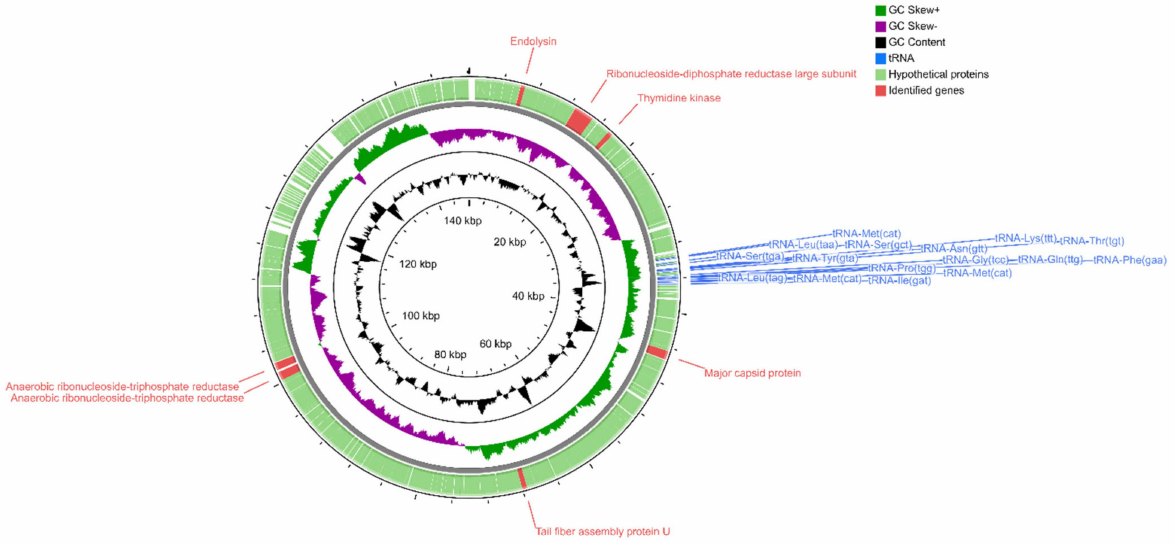
Figure 8. Map of the genome organization of Serratia phage KKP 3264 generated by using the CGView program